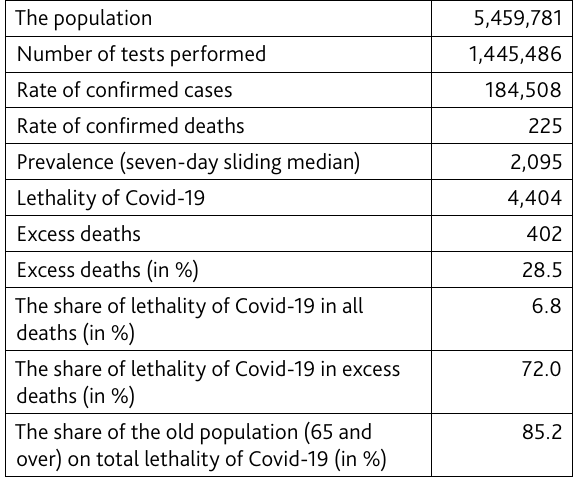
Table 1. Descriptive statistics of basic data on Covid-19